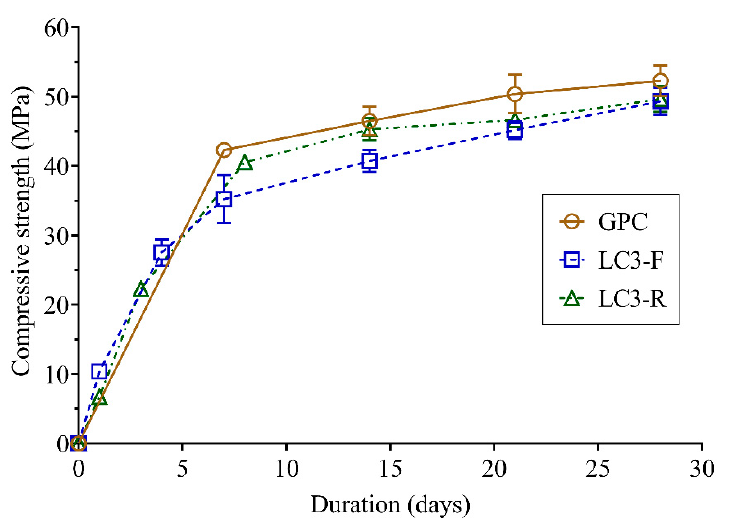
Figure 5. Strength development of concretes until 28 days.